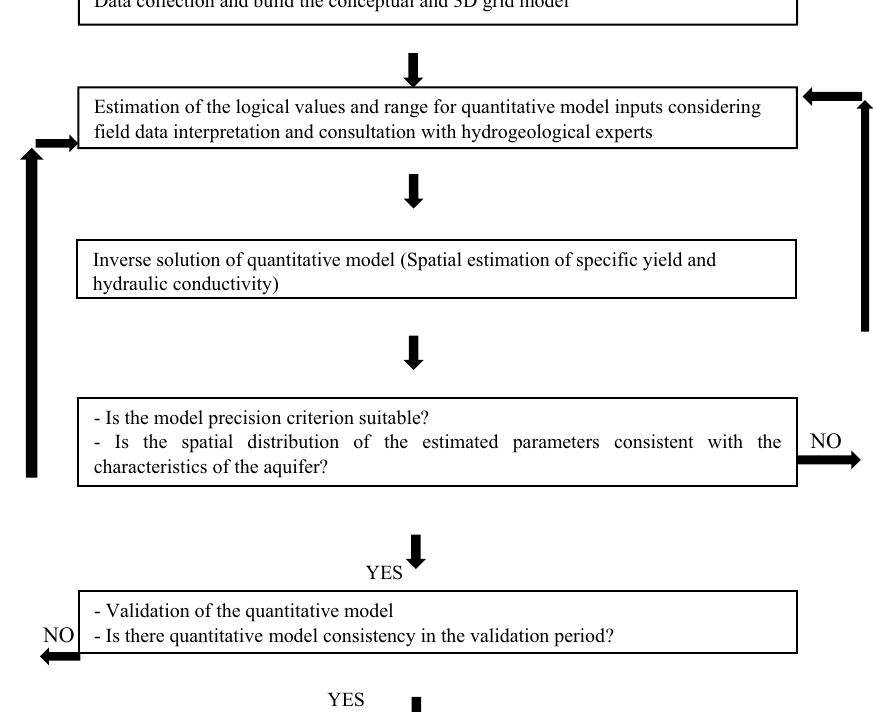
Fig. 4 Flow chart of the com- bined